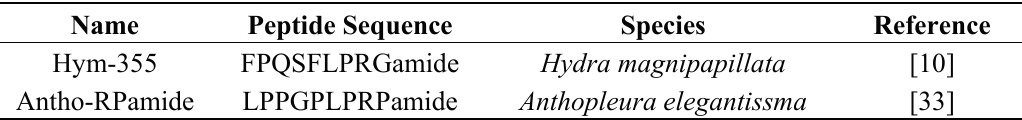
Table 3. PRXamide peptides in